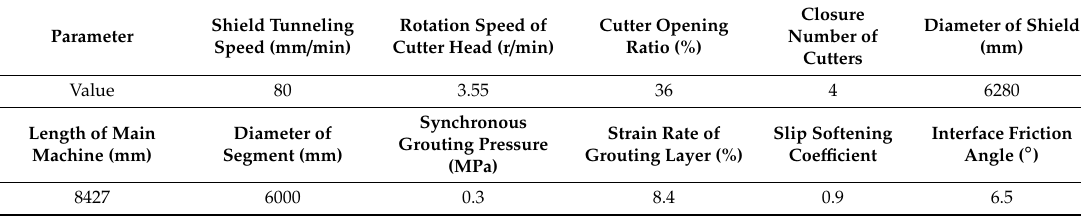
Table 2. Construction parameters of shield